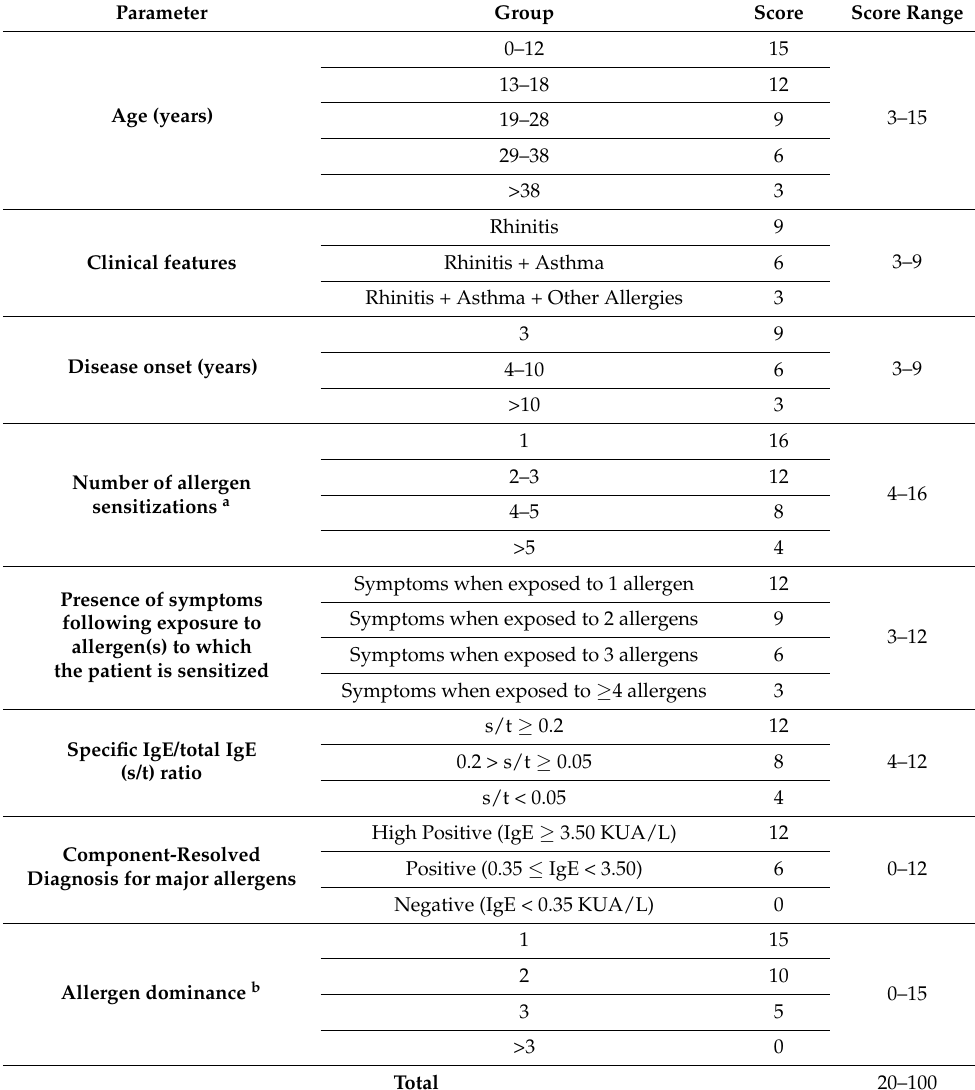
Table 2. Predictive Response to Immunotherapy Score